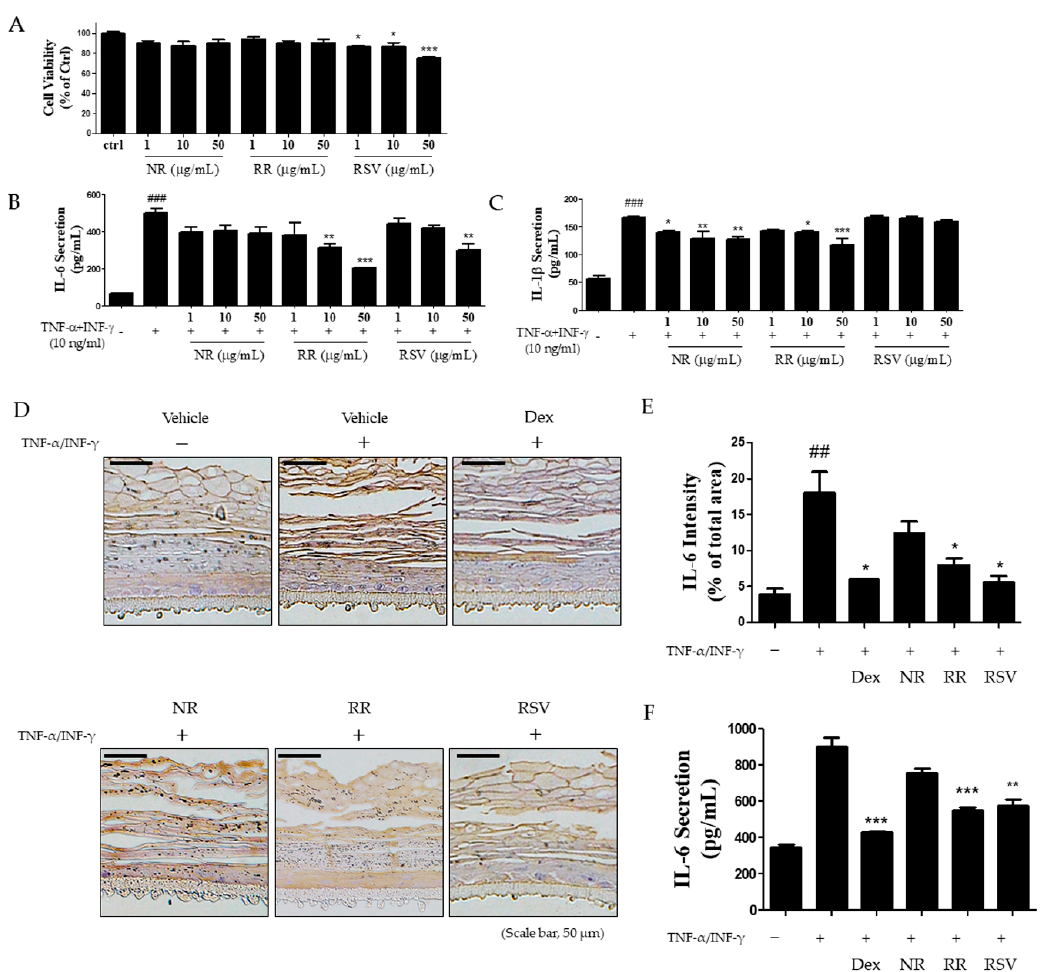
Figure 4. Inhibitory effects of RR on inflammatory cytokine expression in TNF- α /INF- γ -induced HaCaT cells and 3D skin tissue. ( A ) Cells were cultured in 96-well plates and treated with NR, RR, and RSV (1, 10, and 50 μ g/mL, respectively). After 24 h, cell viability was measured using the MTT assay. ( B , C ) Cells were treated with NR, RR, and RSV in the presence of TNF- α /IFN- γ (each 10 ng/mL). After 24 h, IL-6 and IL-1 β levels in supernatants were determined by ELISA. ( D ) The expression of IL-6 in TNF- α /IFN- γ -induced 3D skin model was evaluated by IHC. Vehicle (polyethylene glycol: PBS, 1:1), Dex (1%), NR (1%), RR (1%), and RSV (1%) were applied after TNF- α /IFN- γ treatment in 3D skin model thrice weekly. ( E ) Graphical representation of IL-6 expression in epidermal tissue. Scale bar, 50 μ m. ( F ) The level of IL-6 secretion in media was measured using ELISA. Values are expressed as means ± SEM. ### p < 0.001 versus control group; * p < 0.05, ** p < 0.01, and *** p < 0.001 versus TNF- α /IFN- γ -treated group.